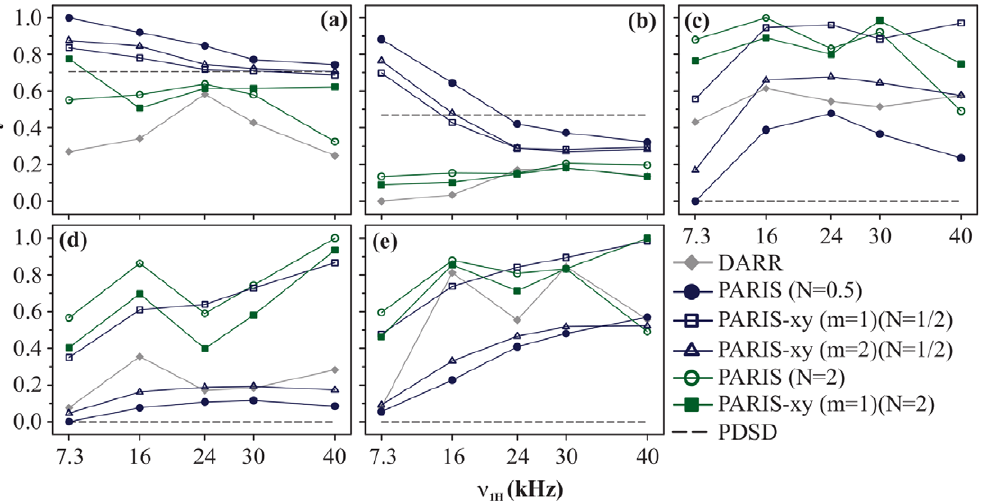
Figure 4. Build-up curves. Magnetisation build-up curves of (a) C a -C b , (b) C d -C e , (c) C a -C c , (d) C a -CO, and (e) C b -CO cross-peaks of U- 13 C-, 15 N- L-histidine : H 2 O for different recoupling schemes applied on the 1 H channel, at n r =30 kHz and B 0 =11.74 T. Each recoupling scheme was applied for a fixed mixing-time period (90 ms) using different RF amplitudes of 7.3, 16, 24, 30, and 40 kHz. M values calculated for individual cross-peaks according to Eq. 1 are plotted as a function of RF amplitude. M values are normalised with respect to the maximum value yielded by PARIS (N=1/2) ( n 1 H =7.3 kHz) in (a and b), PARIS (N=2) ( n 1 H =16 kHz) in (c), PARIS (N=2) ( n 1 H =40 kHz) in (d), and PARIS-xy (m=1)(N=2) ( n 1 H =40 kHz) in (e). Data points are joined with straight lines to guide the readers’ eyes.